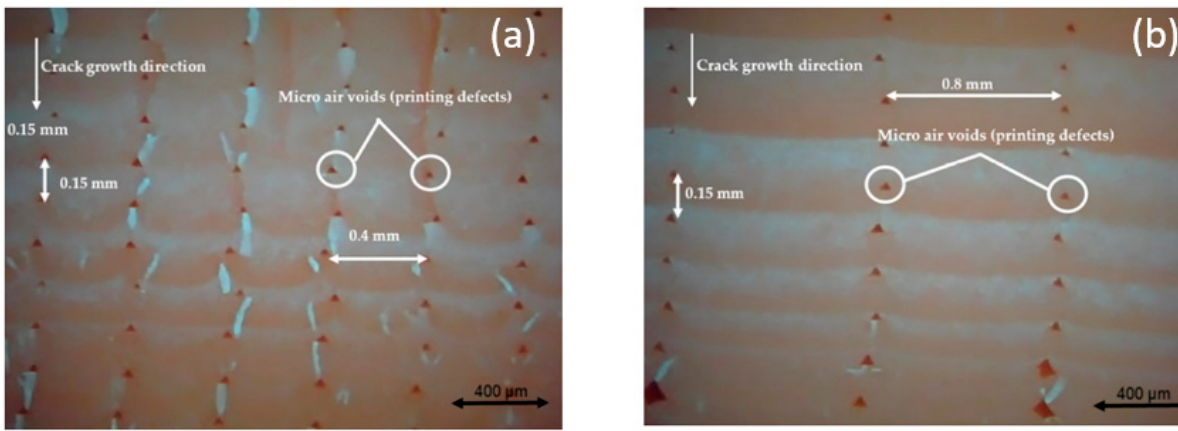
Figure 13. Comparison between the influence of different nozzle sizes of FDM ABS, printed with 0.15-mm layer thickness, X building orientation, and nozzle size ( a ) 0.4 mm and ( b ) 0.8 mm [33].